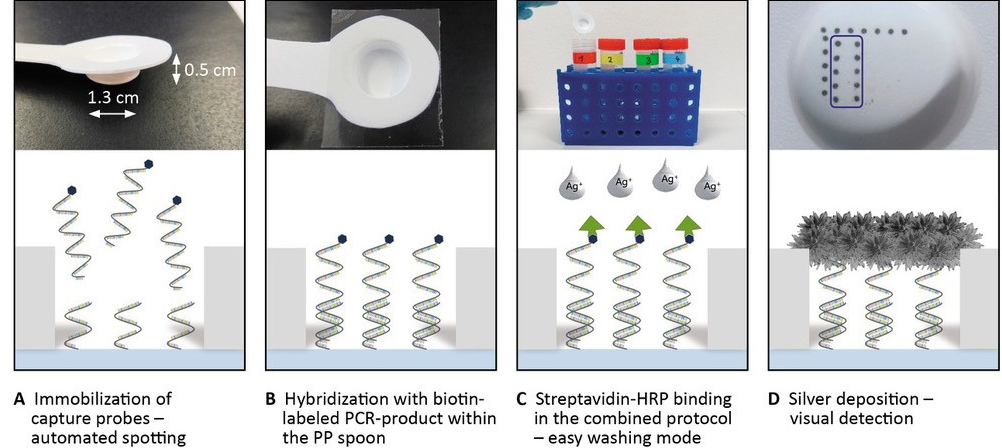
Figure 6. Schematic principle of the chip-based detection system using spoon-shaped PP chips: automated spotting of the capture probe array within the PP spoon cavity ( A ), hybridization of immobilized capture probes with biotin-labelled (blue dot) ssPCR products in the spoon cavity covered with PCR foil ( B ), interaction of the streptavidin horseradish peroxidase complex (green arrow) with biotin ( C ), and enzymatic silver deposition and visual detection ( D ).